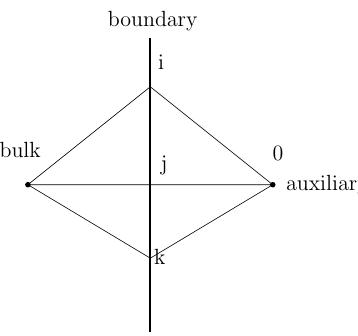
Figure 3: Auxiliary simplices connected to auxiliary vertex